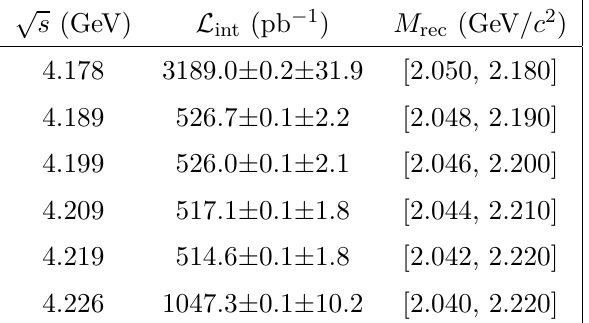
Table 2 . The integrated luminosities ( L int ) and the requirements on M rec for various collision energies. The definition of M is given in eq. (3.1). The first and second uncertainties are rec statistical and systematic,